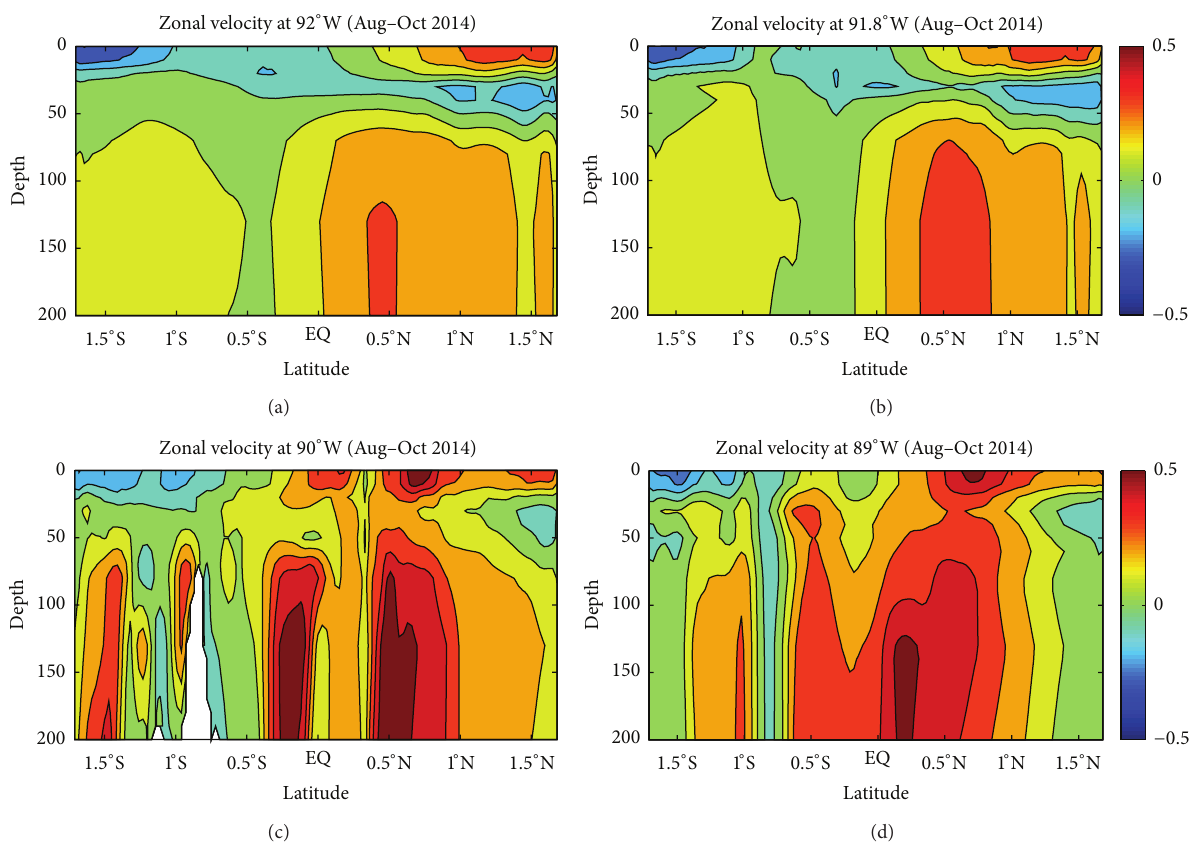
Figure 17: Vertical sections of zonal current (ms −1 ) along 92 ∘ W, 91.8 ∘ W, 90 ∘ W, and 89 ∘ W for the upper 200m around the GMR in Aug–Oct 2014 La Ni˜na